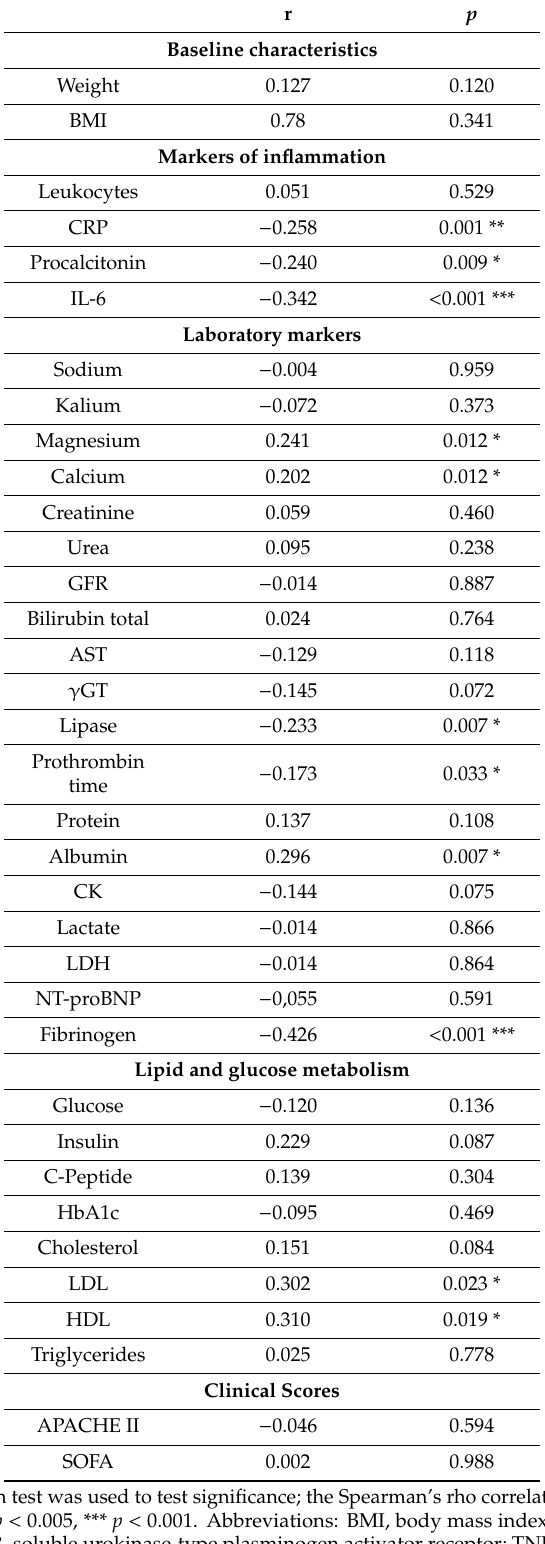
Table 2. Correlations of Myostatin with baseline characteristics, markers of inflammation, other laboratory markers, and clinical scores at day 1 of ICU